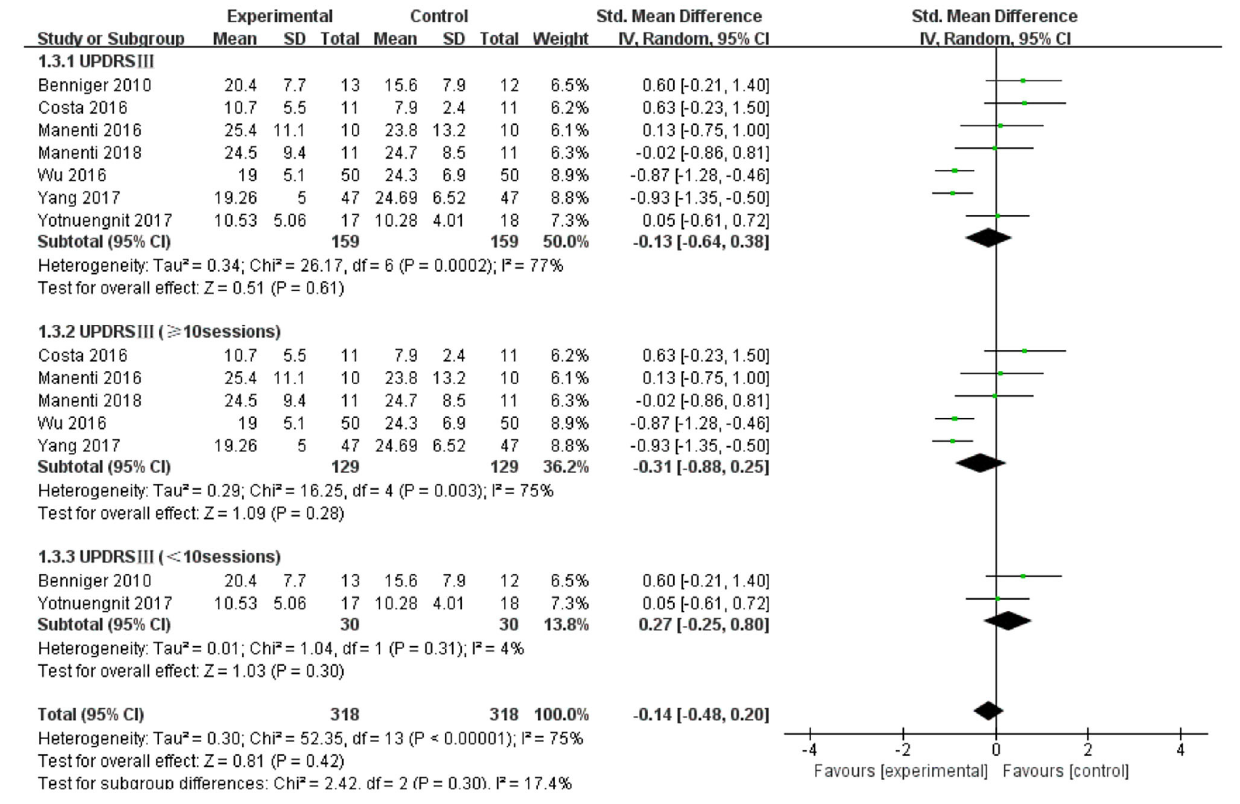
for PD based on the existing evidence. In this review, the high heterogeneity of stimulation parameters does not allow us to firmly conclude that tDCS improves cognitive